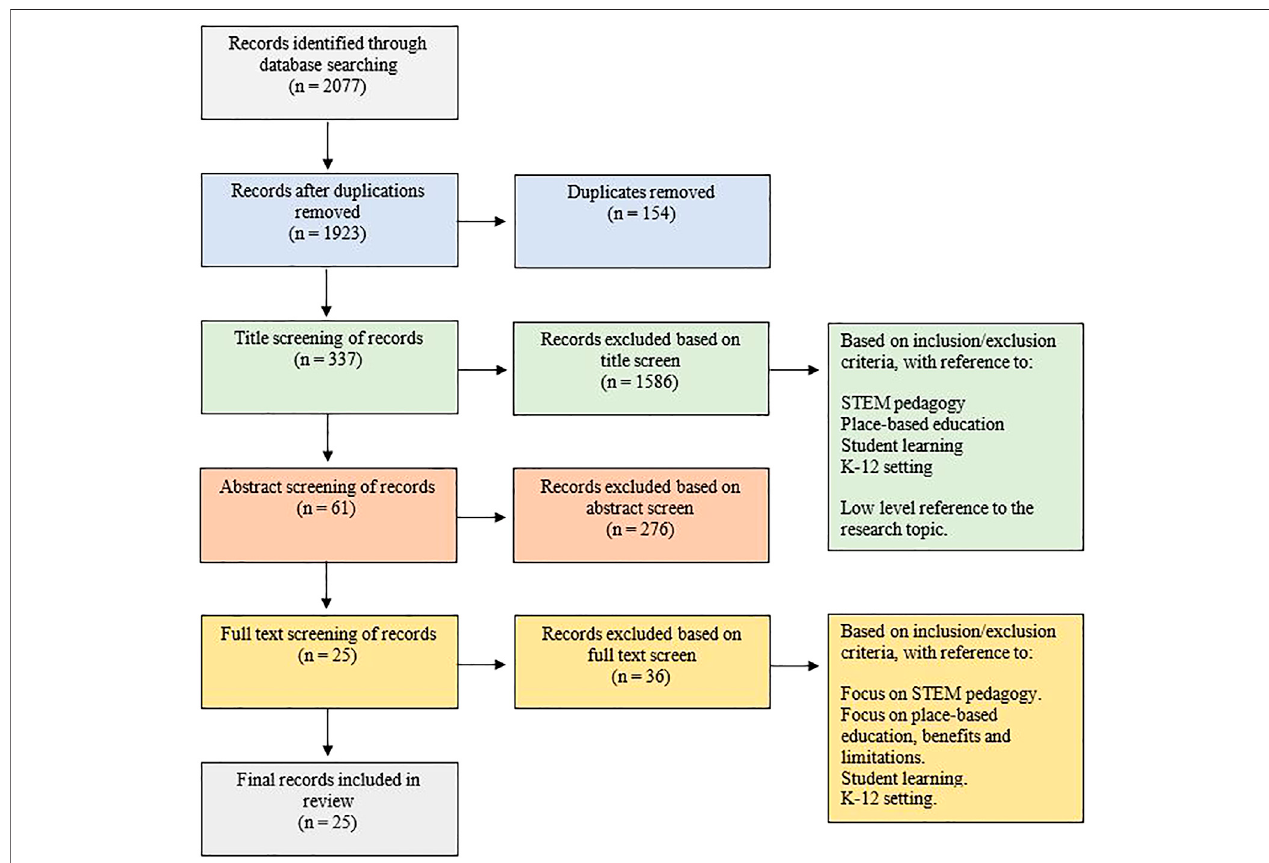
FIGURE 1 | Article selection fl ow diagram developed based on